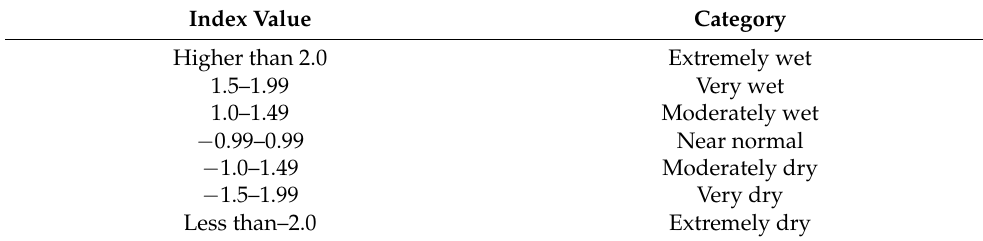
Table 1. The classification of Standardized Precipitation Index (SPI) values (World Meteorological Organization,